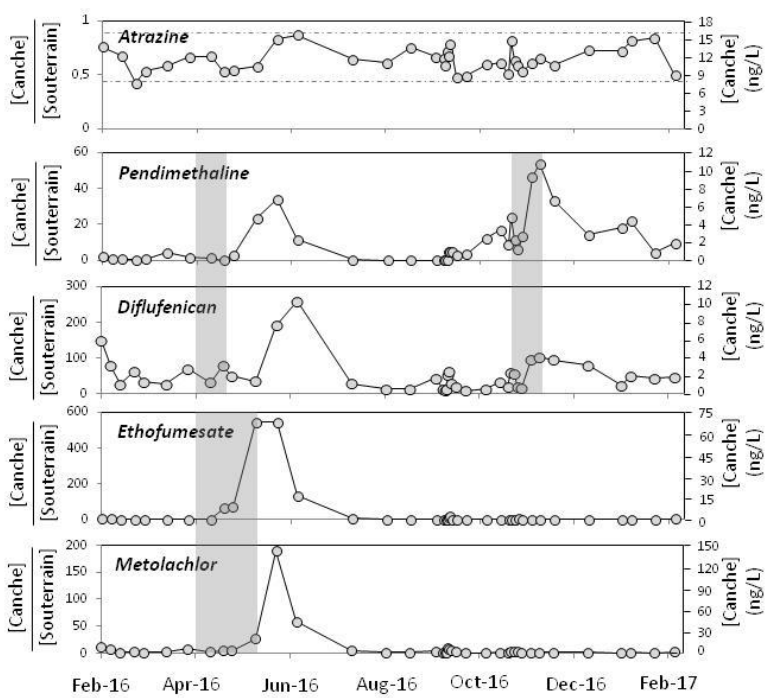
Figure 6. Surface (“Canche”) water to groundwater (“Souterrain”) concentration ratio for pesticides at Canche 5 (left y-axis). Additionally, as shown, the corresponding dissolved concentration (right y-axis). Grey areas refer to the suspected spreading period.